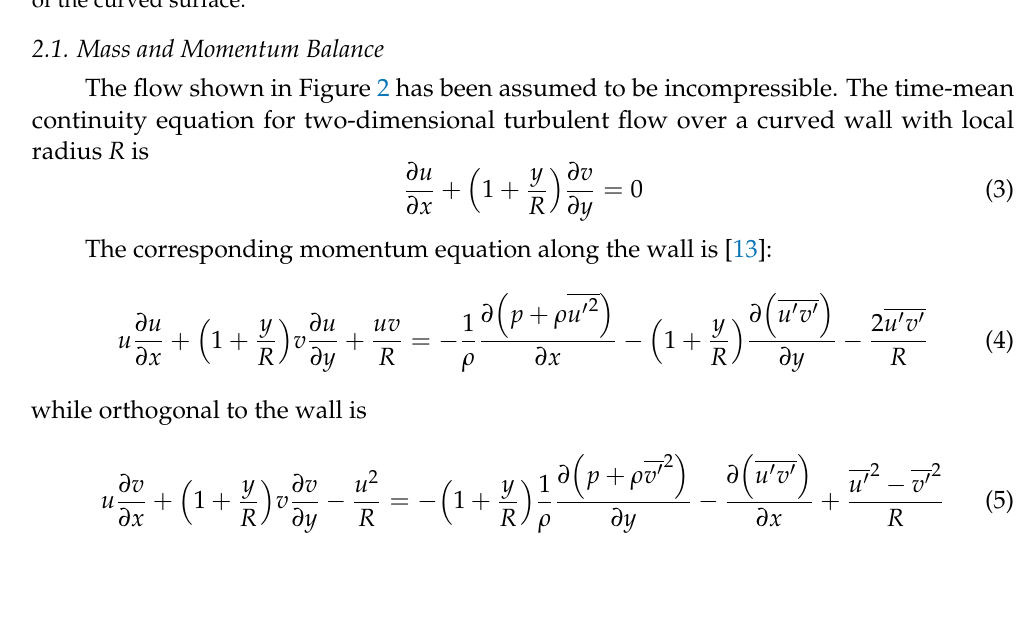
Figure 2. Schematic diagram of a turbulent jet flow over logarithmic spiral wall surface, with a curvilinear x - y coordinate system. The jet exits from a slot height h at a velocity of u i . The R , b , and H represent the local curvature radius, jet half-width, and wall distance deviated from the ground, respectively. The R 0 is the radius of curvature at the starting point of the curve. O is the virtual origin of the curved surface.